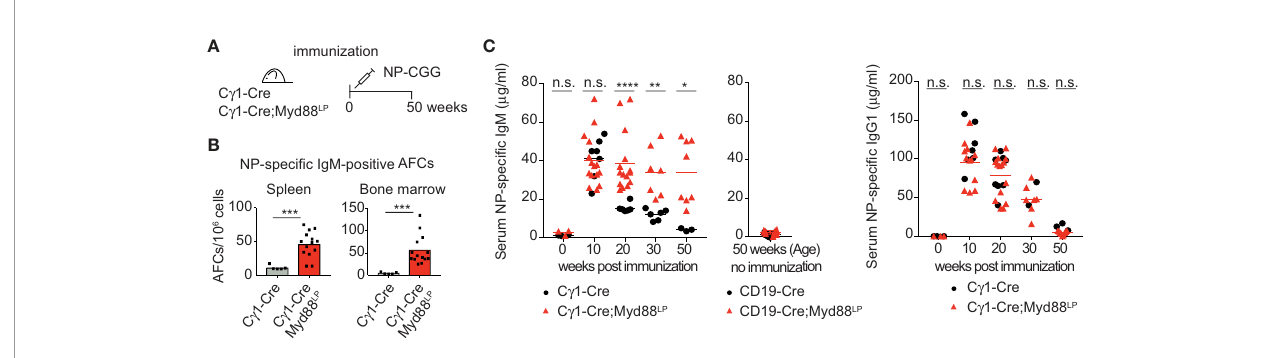
FIGURE 3 | Myd88 L252P causes persistence of antigen-speci fi c IgM plasma cells and serum IgM. (A) C g 1-Cre;Myd88 L252P and littermate control animals were immunized with hapten carrier conjugate (NP-CGG) and analyzed at the indicated time points. (B) ELISPOT analysis in spleen and bone marrow at 50 weeks of age. Antigen-speci fi c IgM secreting antibody forming cells (AFCs) were elevated. (C) Serum immunoglobulin levels measured by ELISA. Antigen-speci fi c IgM titers remained elevated while IgG1 titers declined normally. Results are representative of three (NP-speci fi c IgM) or two (NP-speci fi c IgG1) independent experiments. (B, C) Each symbol represents one mouse (n ≥ 3). *p ≤ 0.05, **p ≤ 0.01, ***p ≤ 0.001, ****p ≤ 0.0001, n.s. = not signi fi cant. (See also Supplementary Figure 6